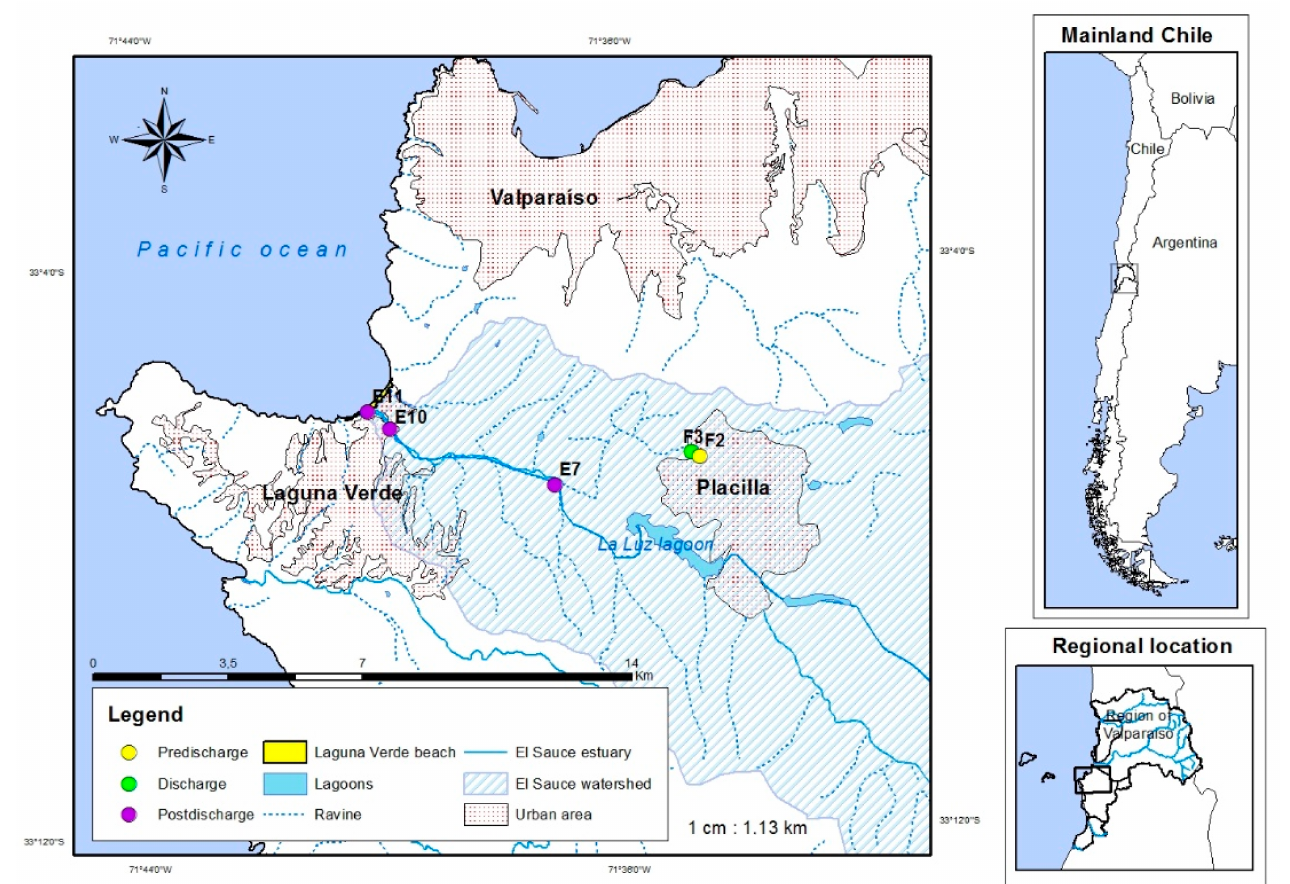
Figure 1. Sampled sites of El Sauce estuary including five